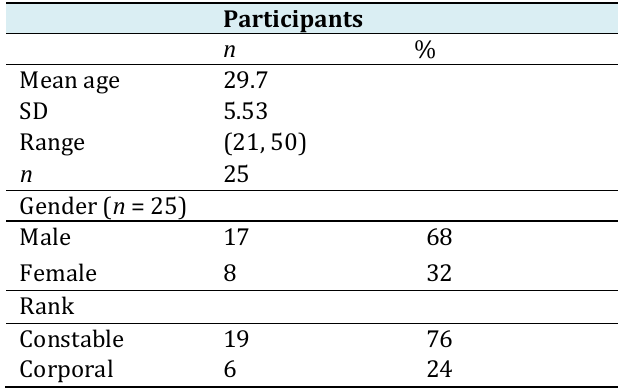
Table 1: Demographics of research